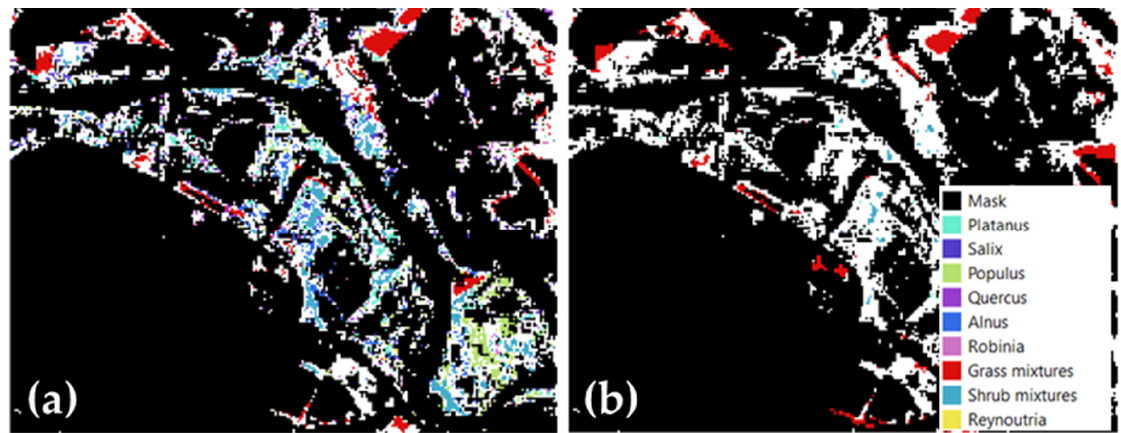
Figure 14. Illustration of the rejection class (in white) with ( a ) RLR-ℓ1 and ( b ) RF classification maps.